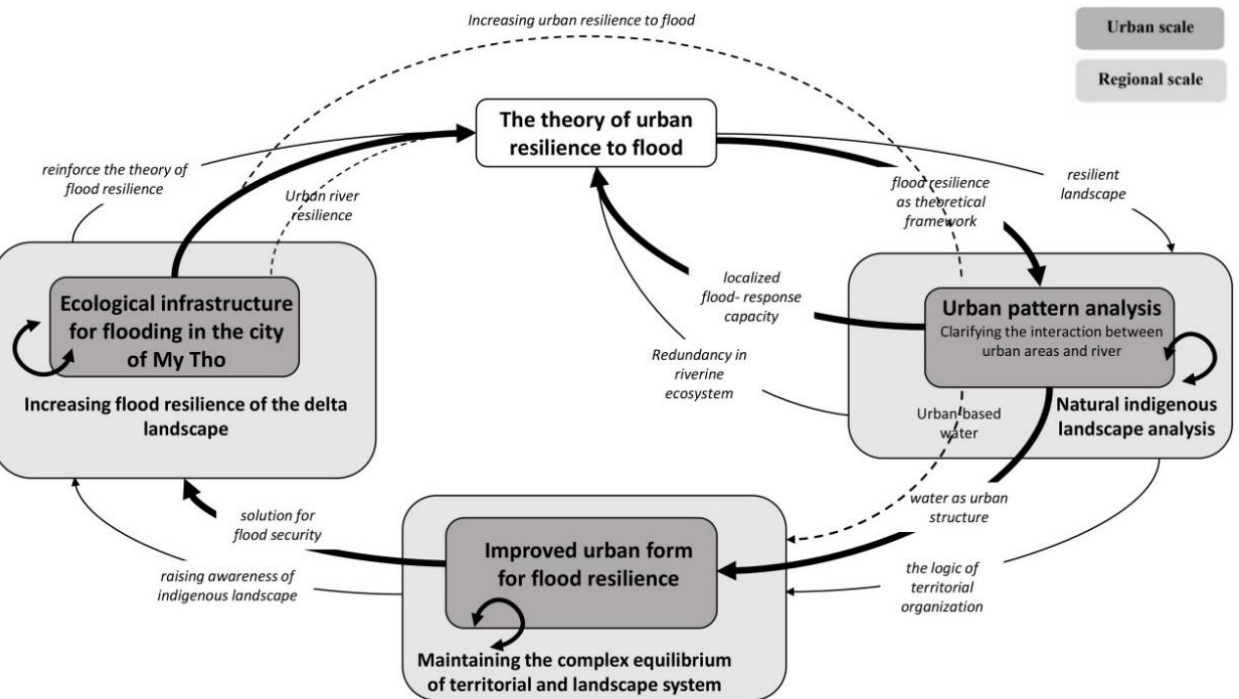
Figure 15. The ecological design framework simulates cross-scale interactions in a sustainable way to enhance the flood resilience of urban and delta ecosystems spatially and temporally.